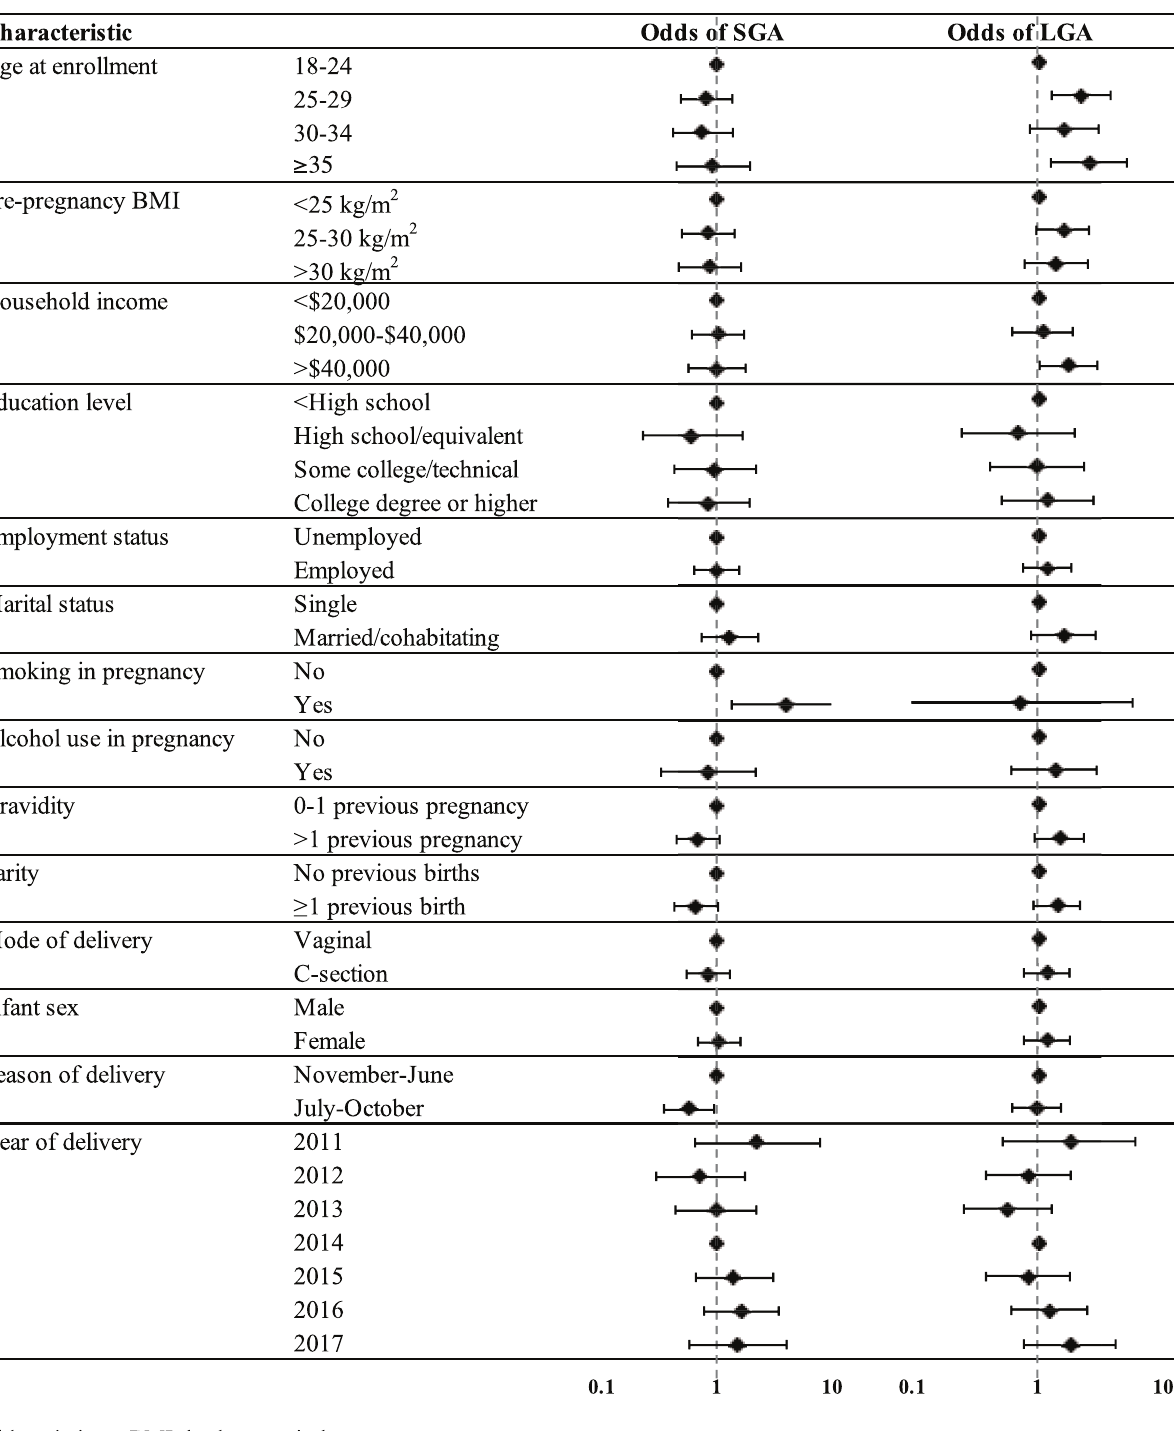
Fig 3. Odds ratios and 95% confidence intervals for delivery of small for gestational age (SGA) and large for gestational age (LGA) newborns in association with demographic and pregnancy characteristics in the PROTECT cohort 2011–2017.